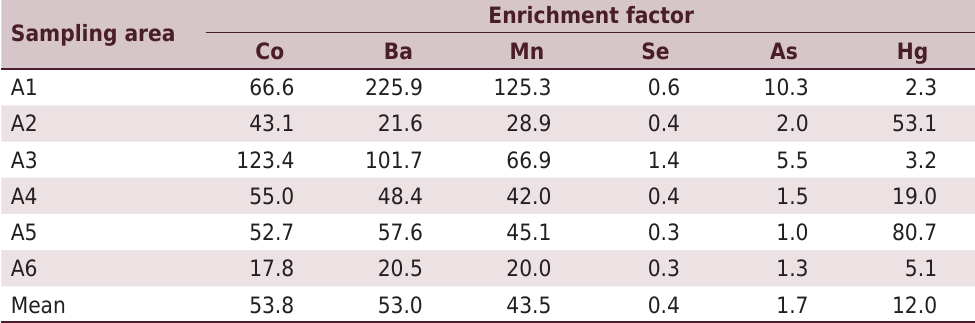
Table 4. Enrichment factor (EF) of potentially toxic elements in soils and sediments from Serra Pelada Sampling